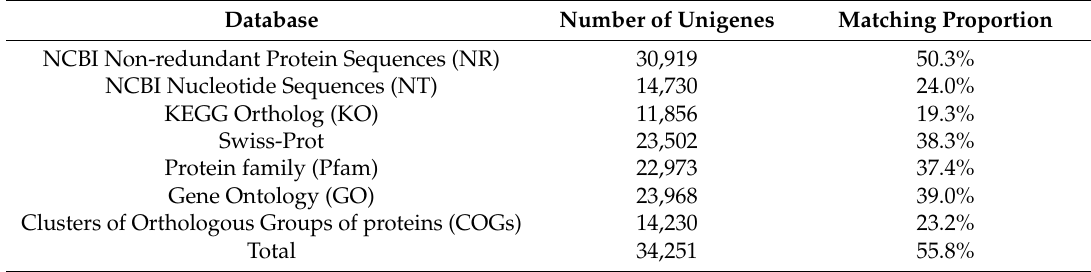
Table 2. Functional annotation of the ramie transcriptome in the seven public databases searched. Database Number of Unigenes Matching Proportion NCBI Non-redundant Protein Sequences (NR)